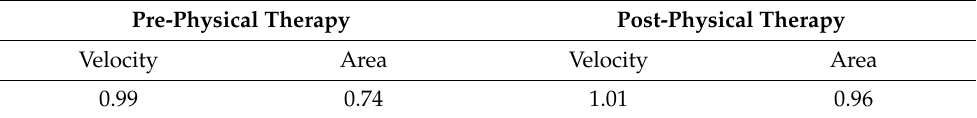
Table 1. Average Romberg Ratio (QR).